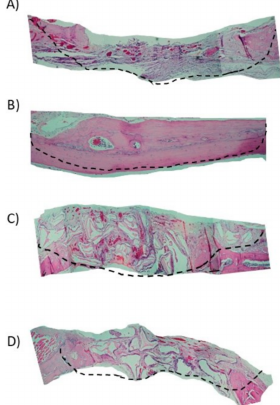
Figure 3. Histological images after 15 days (40 × magnification), the line indicates the region of the bone defect (100 × magnification) . ( A ) Blood clot group (G1); ( B ) autogenous bone group (G2); ( C ) xenogenous bone group (G3); ( D ) xenogenous bone associated with the micro graft group (G4).